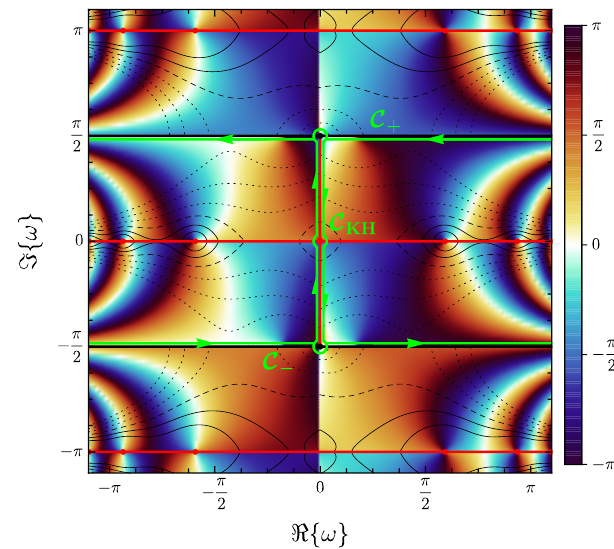
Figure 11: Complex structure of the contour integrand (3.22) in the hyperbolic (cid:1) / ω -plane for the odd sum over the ln ( 2 Γ ) − ln (cid:0) Φ 2 2, together with the contour m m C = C + + C − + C . Since this is the correction of the surface field to the open bound- KH aries, the some kind of regular part from the contours C ± is zero and only the non- trivial keyhole contour C contributes. Note that there is no explicit dependency KH on x and thus we do not need to distinguish between the ordered and unordered phase. For the colour coding see Fig.